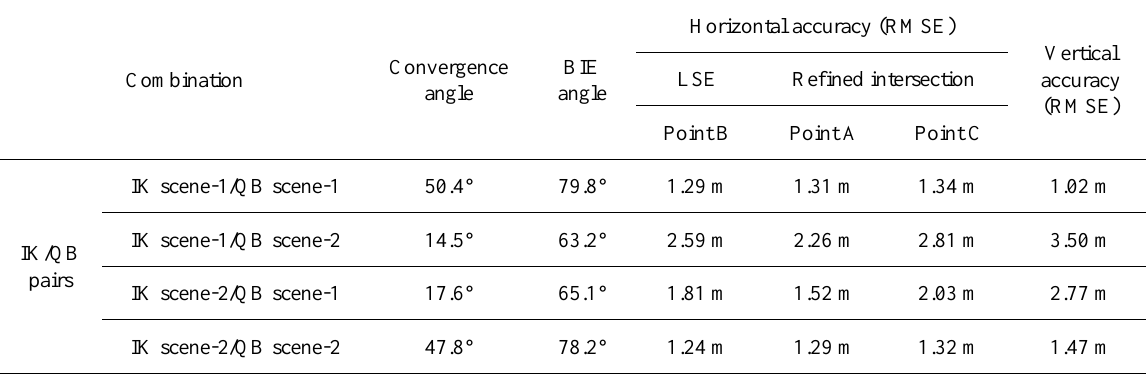
Table 4. Comparison of the positioning accuracy using different intersection calculation